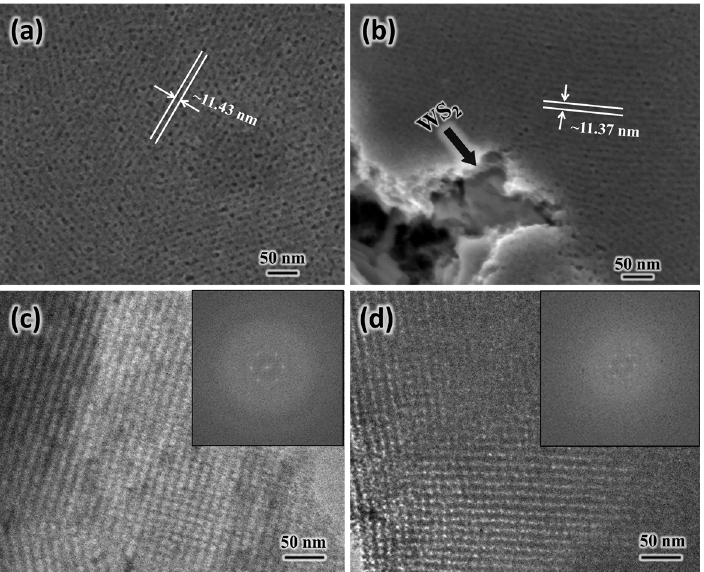
Figure 4. ( a , b ) SEM and ( c , d ) TEM images of ( a , c ) undoped mesostructured TiO 2 and ( b , d ) WS 2 - doped mesostructured TiO 2 films. The insets in ( c , d ) show the corresponding FFT patterns.